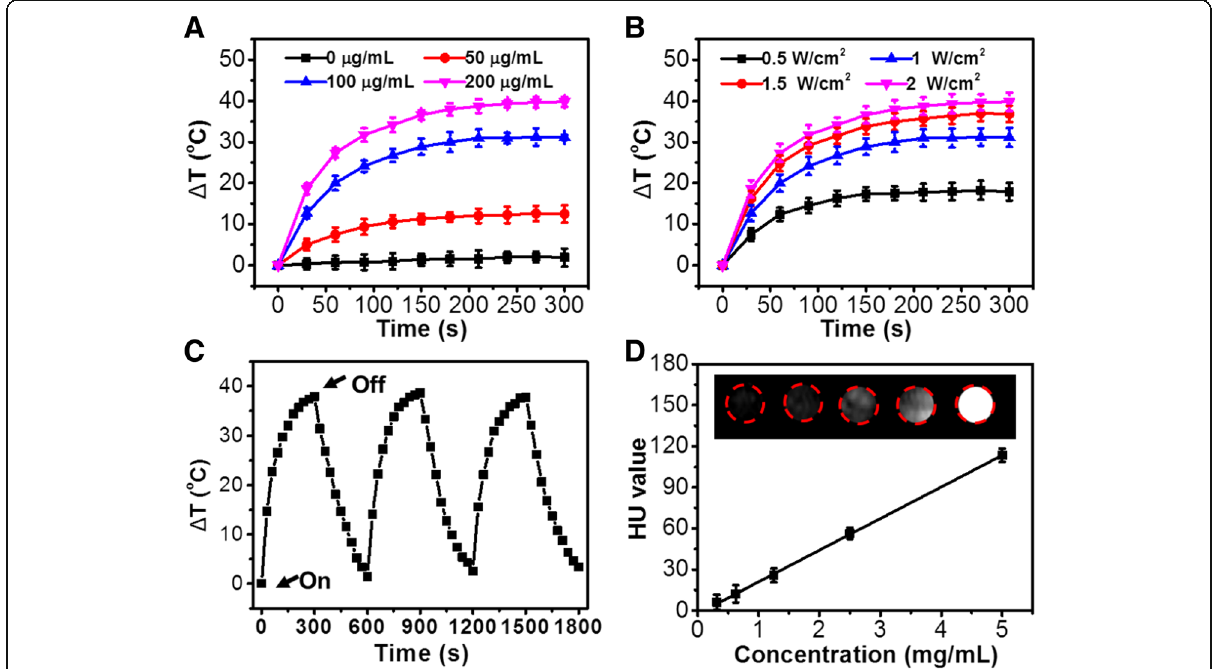
Fig. 2 a Photothermal heating curves of FA-MoSe 2 @BSA NSs solution at different concentrations (0, 50, 100, and 200 μ g/mL) under 808 nm laser irradiation at the power density of 1 W/cm 2 . b Photothermal heating curves of FA-MoSe 2 @BSA NSs solution at 100 μ g/mL under 808 nm laser irradiation at different power density (0.5, 1, 1.5, and 2 W/cm 2 ). c Temperature variations of FA-MoSe 2 @BSA NSs under three cycles of 808 nm laser irradiation at the power density of 1 W/cm 2 . d CT images (inset) and HU values of FA-MoSe 2 @BSA NSs with different